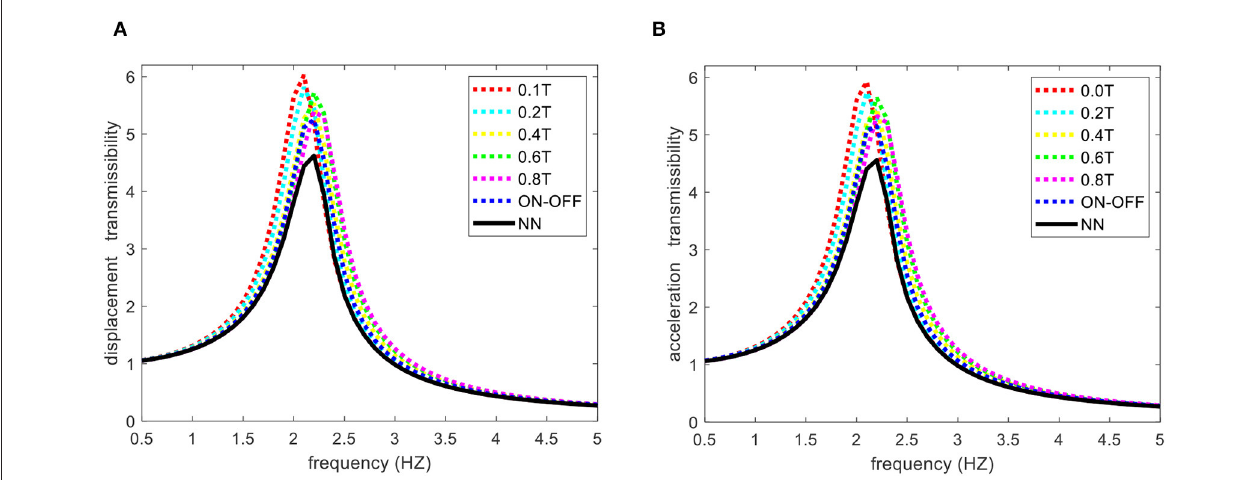
FIGURE 8 | (A) Displacement, and (B) acceleration transmissibility of the human body ( x d ) with respect to the excitation frequencies in the presence of various controllers.